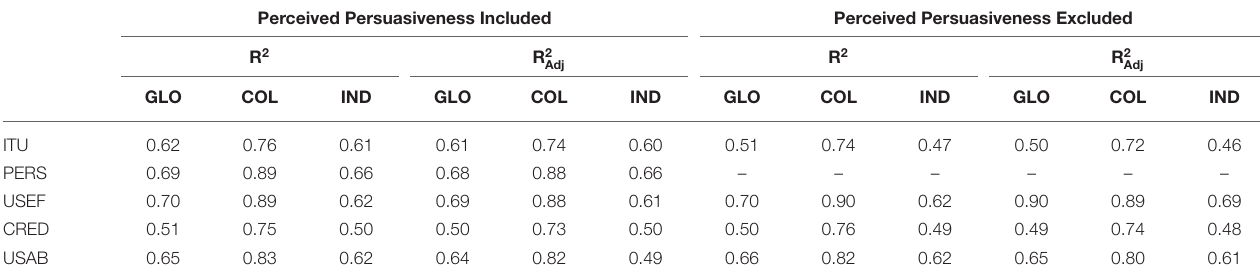
TABLE 3 | Coefficient of determination of intention to use with and without perceived persuasiveness in the persuasive technology acceptance model. Perceived Persuasiveness Included